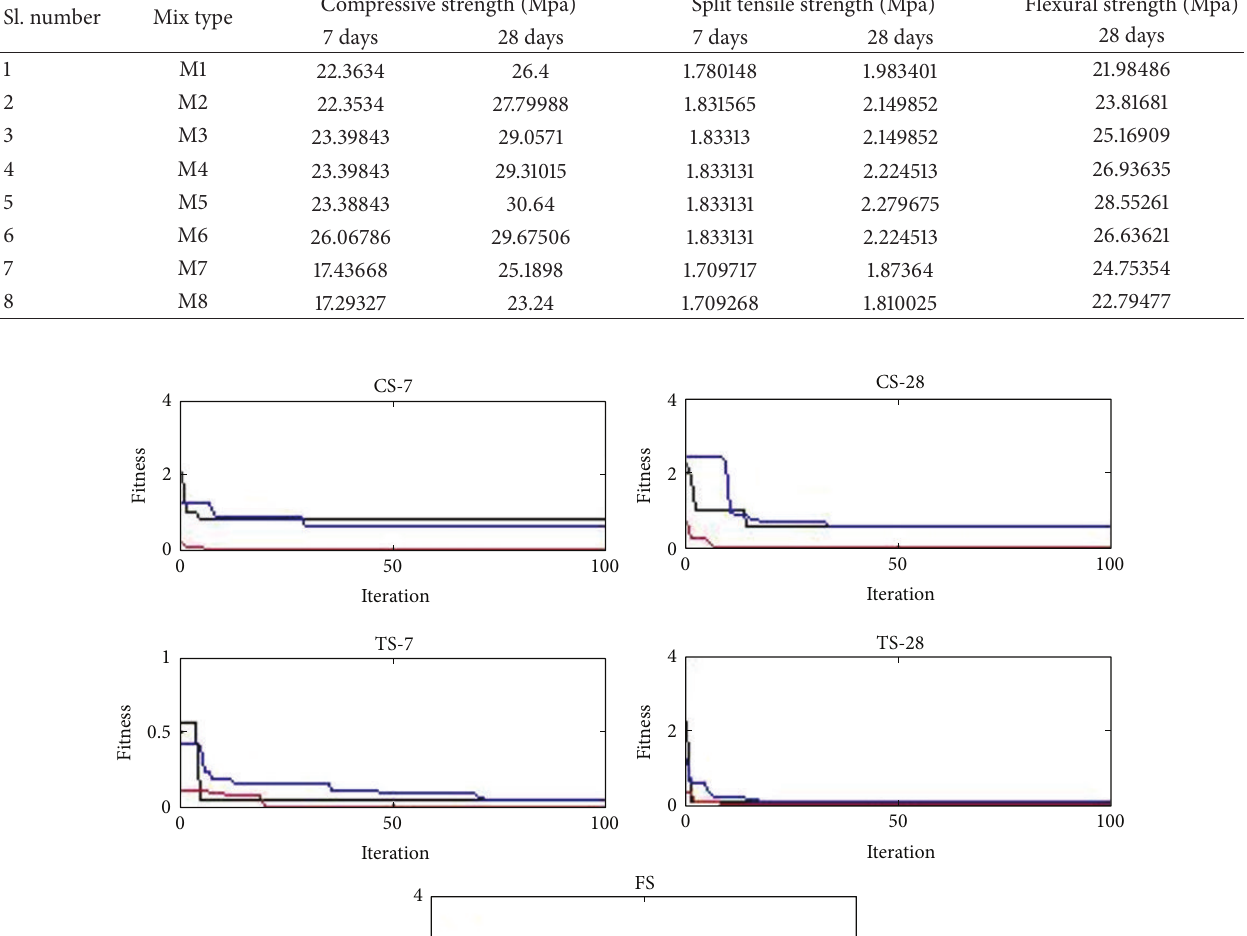
Table 4: Compressive strength split tensile strength and flexural strength for mixing concrete. Sl. number